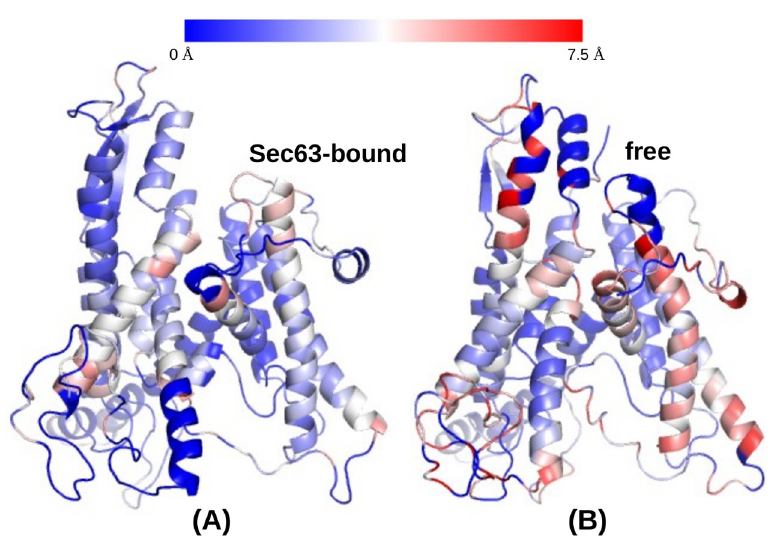
Fig 4. RMSD between the final conformations (at 1 μ s) of Sec61 of (A) Sec63-bound state and (B) free state, and the starting modeled structures shown in Fig 1. Smaller RMSD deviations are represented by blue color and larger deviations are colored red, see color bar on